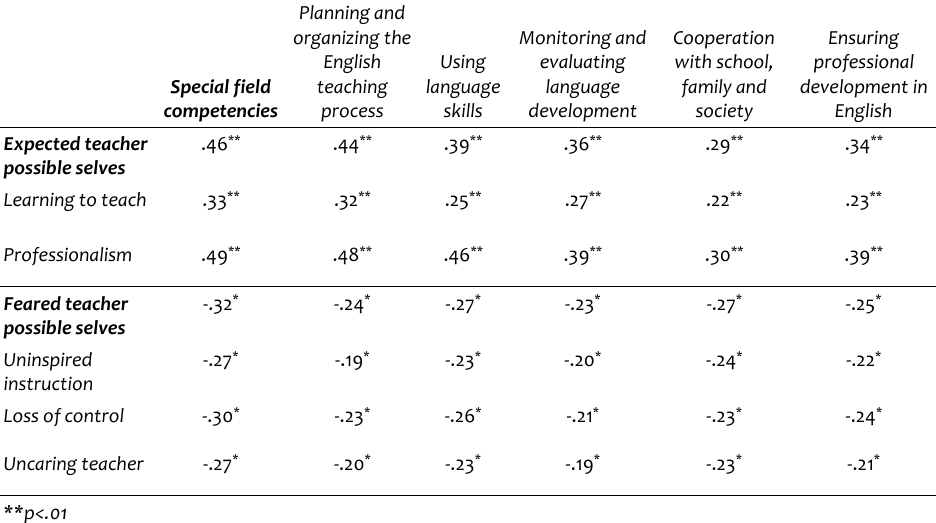
Table 3. The results of Pearson correlation analysis to determine the relationship between preservice English teachers’ possible selves and special field competencies